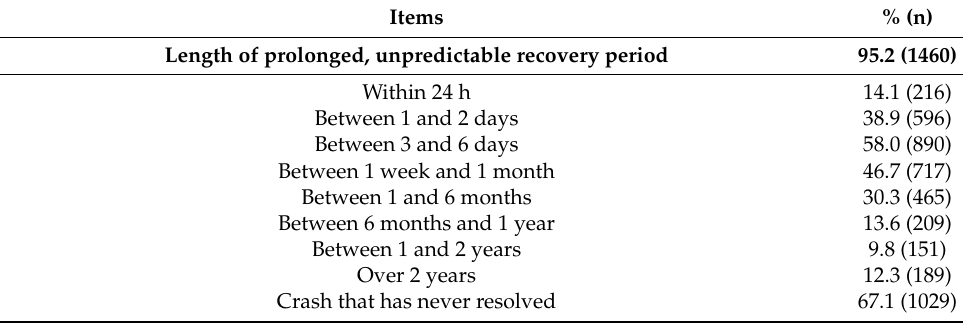
Table 6. Duration of PEM, illness course, and functioning ( N =